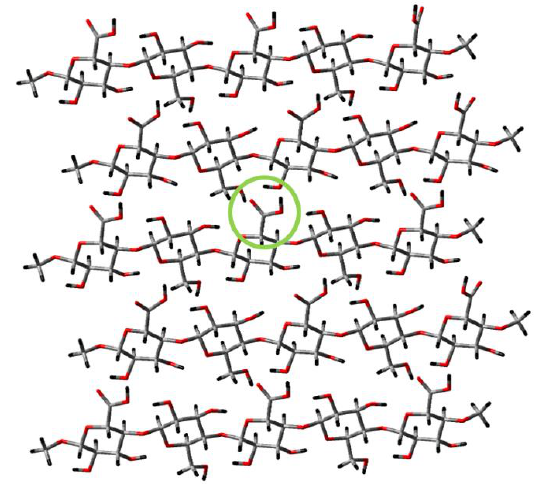
Figure 3. Computational model depicting the TEMPO-oxidized cellulose surface, featuring five parallel cellulose strands capped by methyl groups on each end. The geometry of the layer was optimized using Gaussian computational chemsitry software via semi-empirical PM3 calculation, and the colors of the atoms correspond as such—grey for carbon, red for oxygen, and black for hydrogen. The green ring highlights one of the carboxylate groups on the surface generated during the TEMPO oxidation process. This functional group is used as a chemical modification point for the nanocellulose structures.